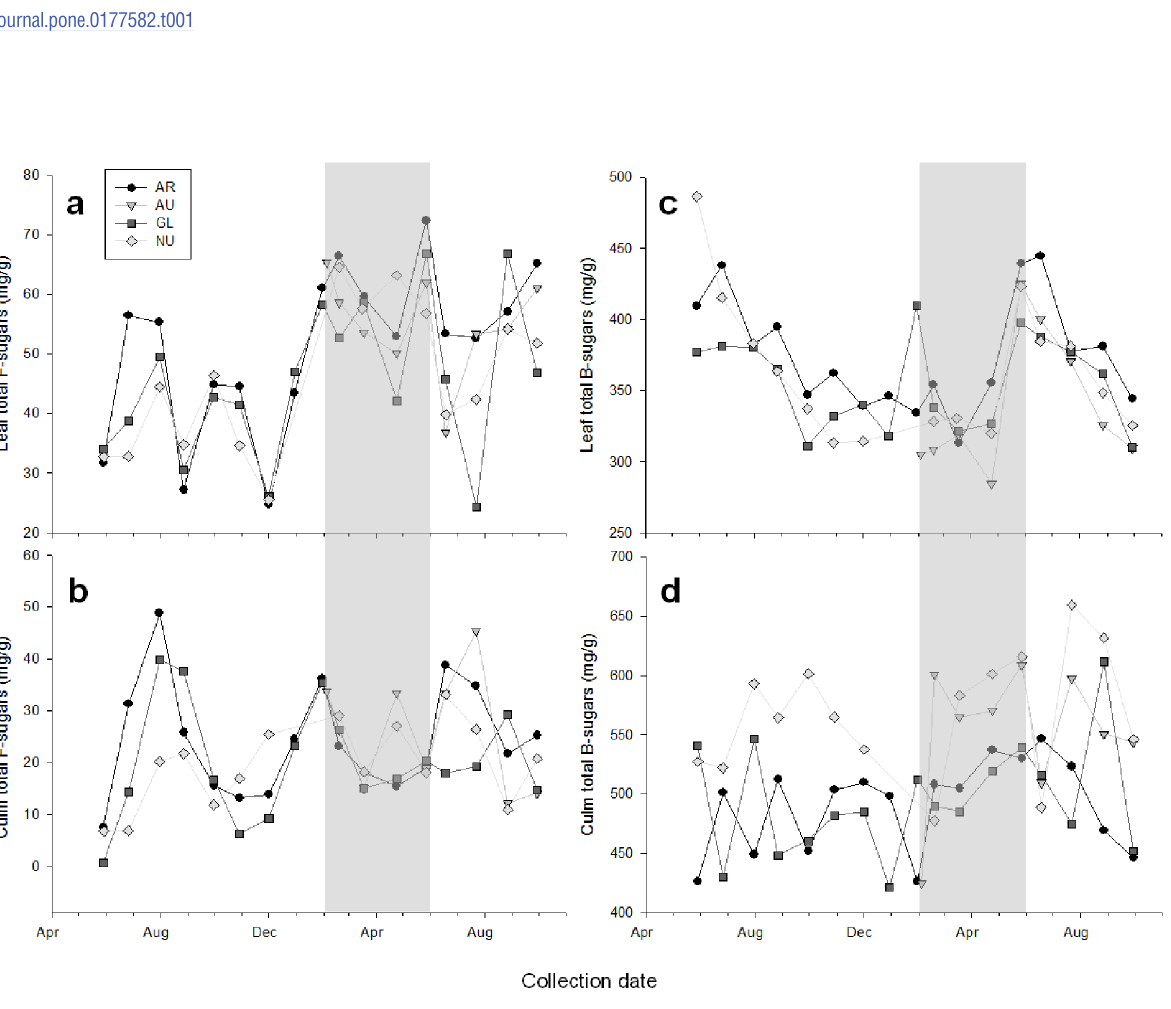
Fig 2. Sugars in bamboo leaves and culm. Total free sugars (panela, b) and boundsugars (panelc, d) sugars in leaf and culm of bamboospecies Phyllostachys ( P .) aurea (AR), P . aureosulcata (AU), P . glauca (GL), and P . nuda (NU) expressedon a dry matter (DM) basis. Samples were collectedonce per month over a periodof 18–27 months. The shadedarea representsthe time when captive giant pandasconsumedprimarilyculm.